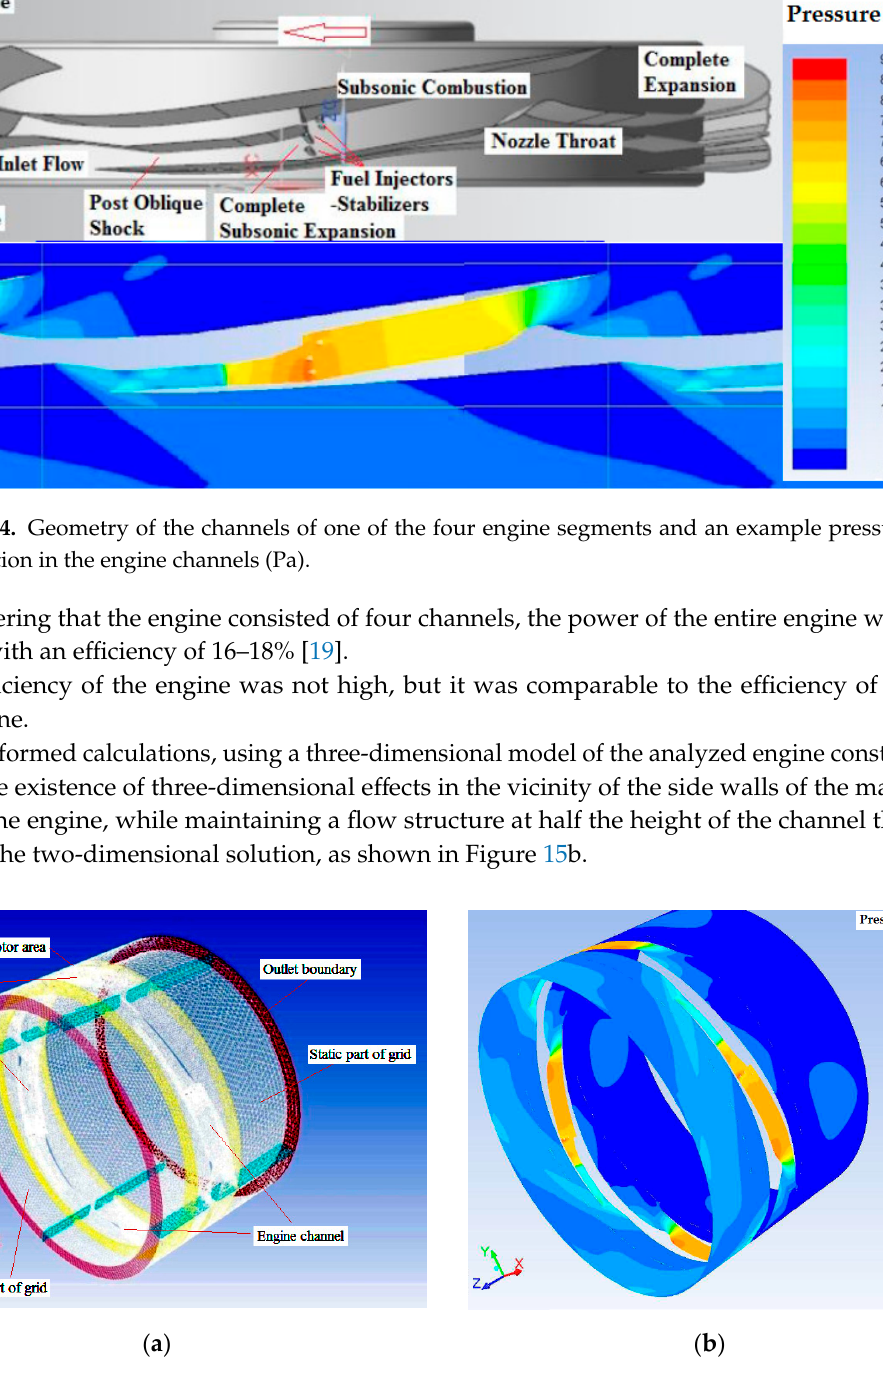
solution. Figure 16. Distribution of the flow velocity (m/s) relative to the single-rotor engine ( M = 2.5).